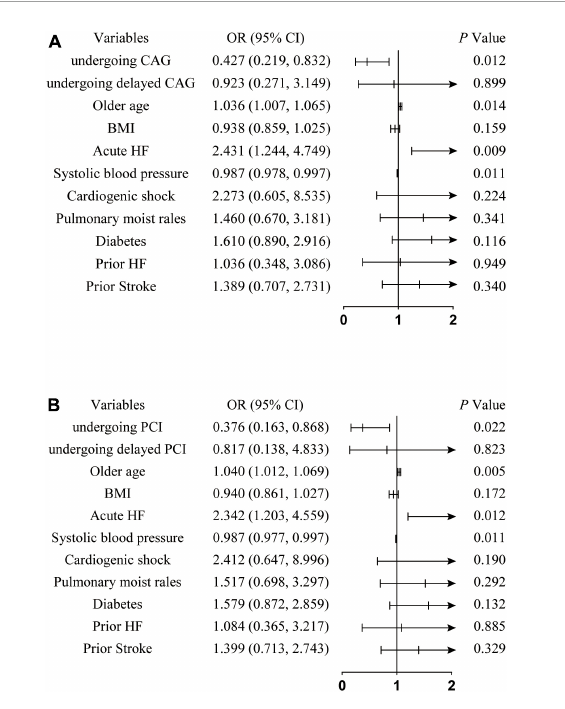
FIGURE2 Forest plot of odds ratio for the rate of MACEs of NSTEMI patients. (A) Represents the independent effects of undergoing CAG on the incidence of MACEs; (B) represents the independent effects of undergoing PCI on the incidence of MACEs. NSTEMI, non-ST segment elevation myocardial infarction; MACEs, major adverse cardiac events; OR, odds ratio; CI, conference interval; CAG, coronary angiography; HF, heart failure; BMI, body mass index; PCI, percutaneous coronary intervention.